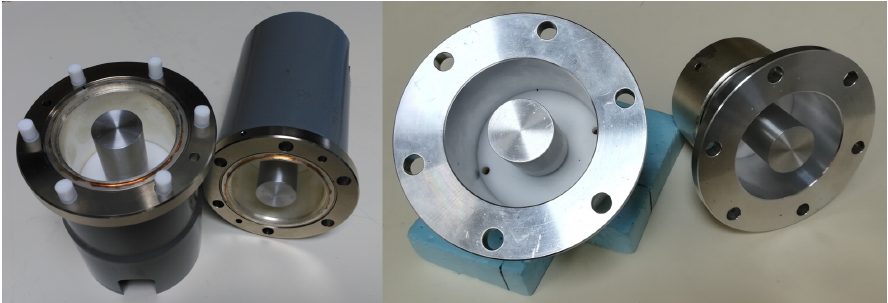
Figure 24. Sample holder improvement to perform measurements according to ASTM D4935: com- mercial sample holder ( left ) and upgraded sample holder ( right